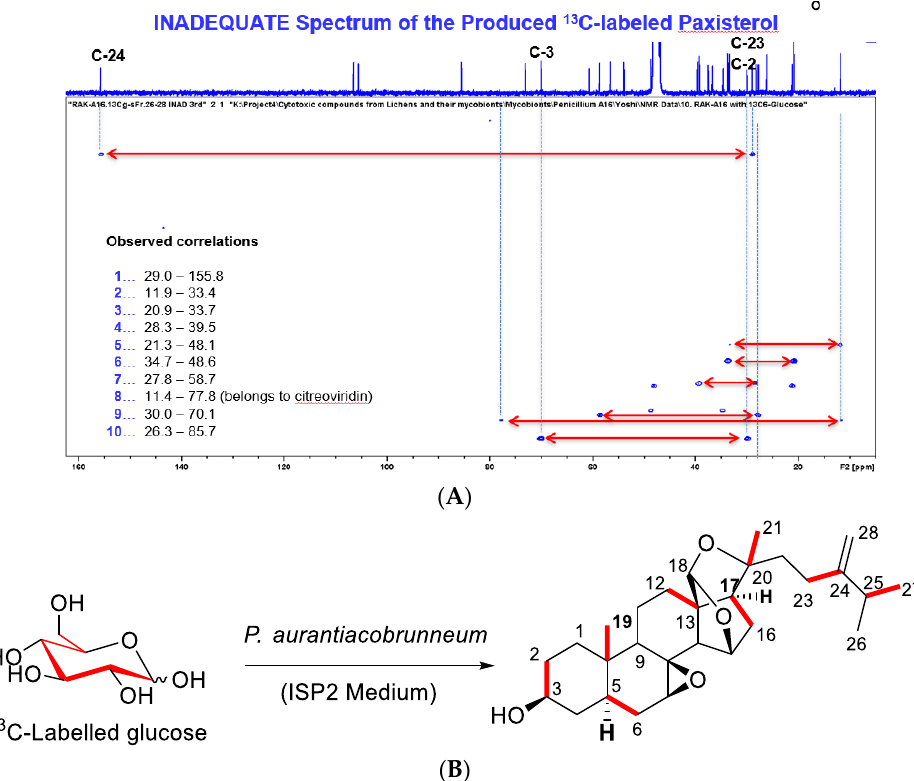
Figure 2. ( A ) Inadequate spectrum of 13 C-labelled paxisterol ( 1 ); the one-dimensional 13 C NMR of 1 was used for identification, red arrows are couples carbons; ( B ) structure of 13 C-labelled paxisterol ( 1 ); red lines are identified 13 C- 13 C bonds.